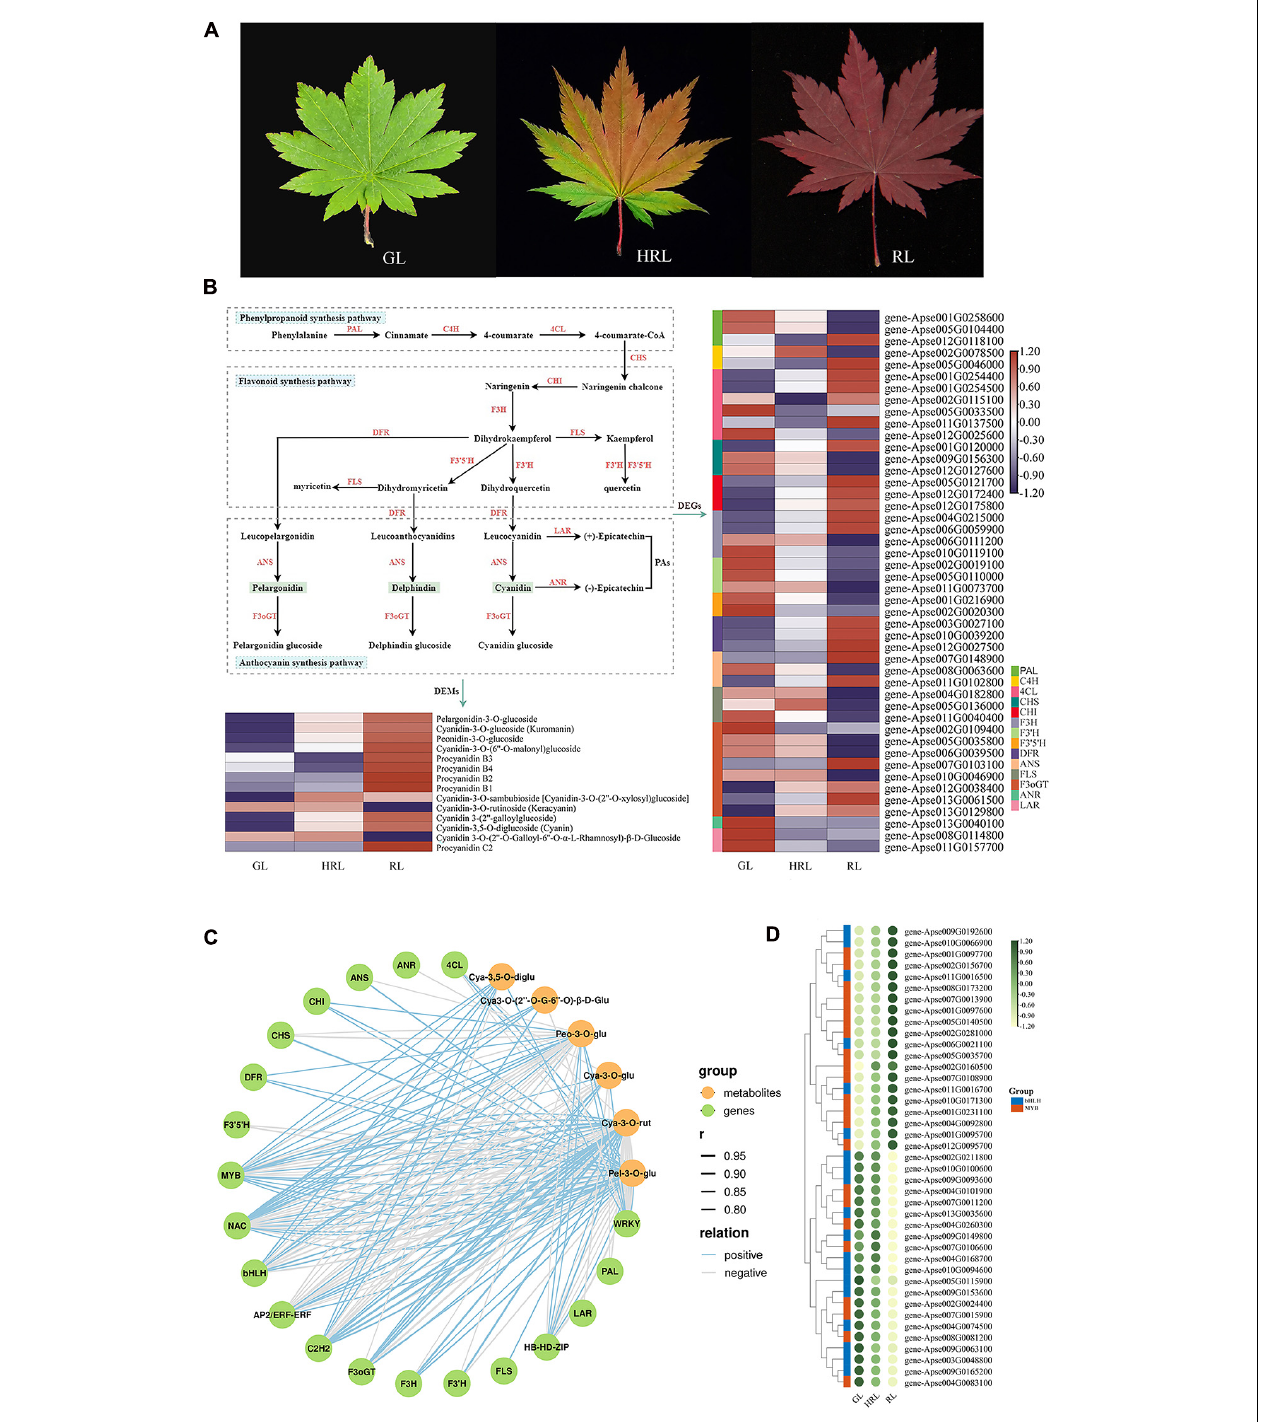
FIGURE 5 | Comparative transcriptomic analysis of genes involved in anthocyanin biosynthesis during leaf color change. (A) Photographs of different leaf colors of A. pseudosieboldianum . GL, green leaf; HRL, half-red leaf; RL, red leaf. (B) The biosynthesis pathways of flavonoids, anthocyanin and flavonoid and the expression analysis of differentially expressed genes and differentially expressed metabolites. (C) Correlation network of metabolite-related genes involved in anthocyanin biosynthetic pathways. r represents the Pearson correlation coefficient; relation represents the correlation, including positive ( r > 0.8) and negative correlations ( r < –0.8). (D) Heatmap showing the differential expression of MYB and bHLH transcription factors according to the transcriptome data from leaves of different colors.